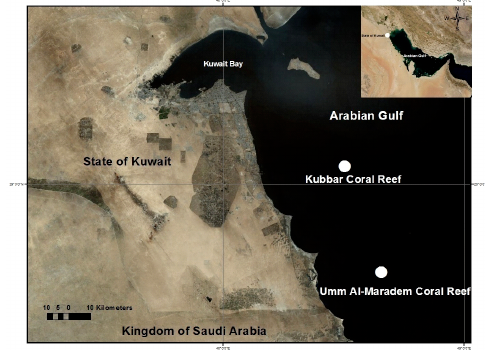
Figure 1: Map Showing the Location of the Selected Kuwait's Coral Reef (Kubbar and Umm Al-Maradem (ESRI, 2011)